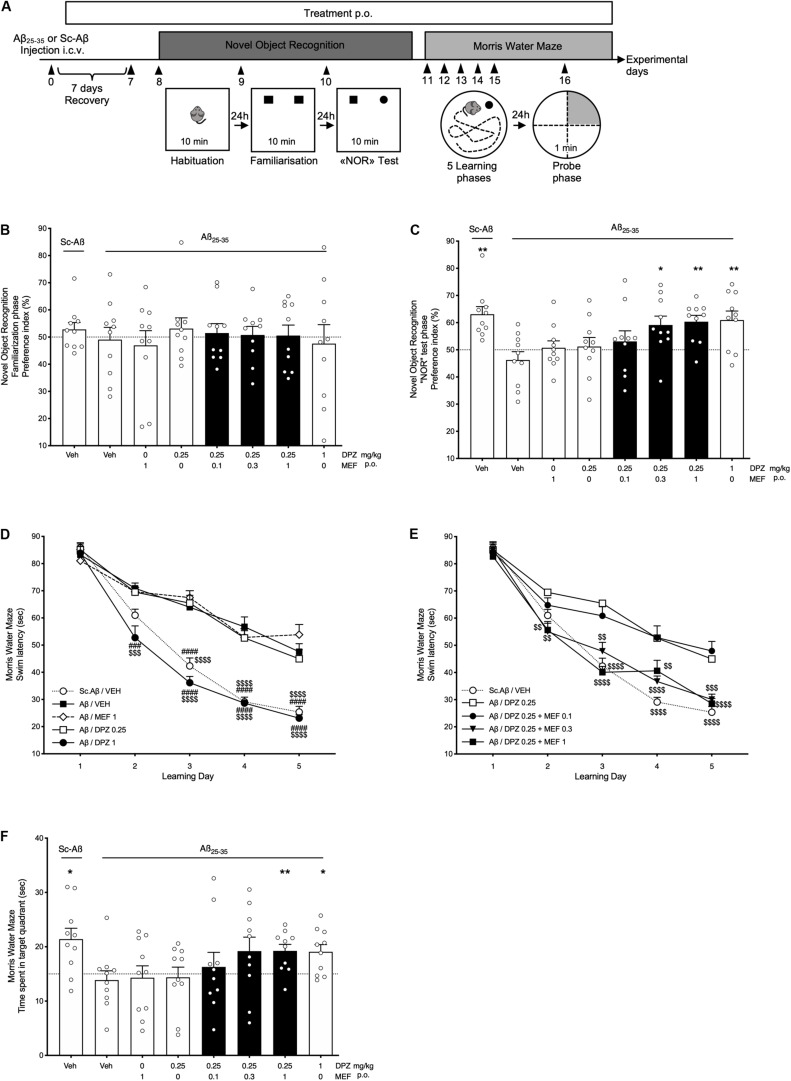
Behavioral performances in Aβ25–35 or scramble-Aβ peptide-injected mice. Effects of donepezil and/or mefloquine (MEF). (A) Experimental design. (B–F) Mefloquine (0.1, 0.3, 1 mg/kg), donepezil (DPZ, 0.25, 1 mg/kg), or vehicle (veh, DMSO 2%) was administered p.o. daily, from the day after i.c.v. injection (day 1) of Aβ25–35 peptide (Aβ) or scramble-Aβ peptide (Sc.Aβ) until the last day of experiment (day 16). From days 8 to 10, the preference index for identical objects (B) and novel object (C) in the open field was recorded for 10 min. One-sample t-test: ∗P < 0.05 and ∗∗P < 0.01 vs chance level. (D,E) Swim latency to reach an immerged platform was assessed in the Morris water maze test from days 11 to 15. Two-way repeated-measures ANOVA followed by Tukey multiple-comparisons test: ###P < 0.001, ####P < 0.0001 vs Aβ/veh, $$P < 0.01, $$$P < 0.001, $$$$P < 0.0001 vs Aβ/DPZ0.25. (F) Time spent in target quadrant during the probe test (day 16). One-sample t-test: *P < 0.05 and **P < 0.01 vs chance level. (B–F) Bars in black indicate combination treatments. Data are expressed as mean ± SEM, n = 10 mice per group.